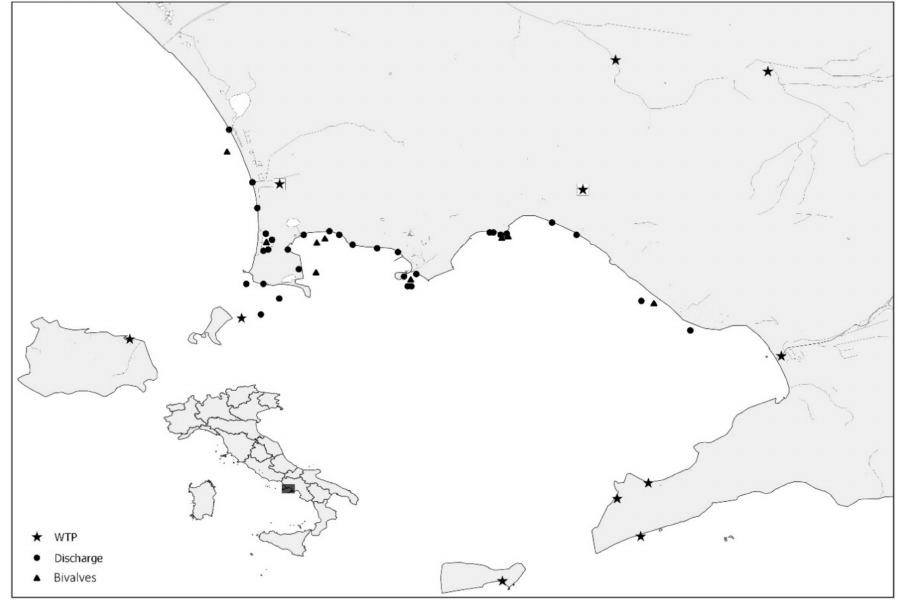
Figure 1. Geolocation of collection sites for water and bivalve